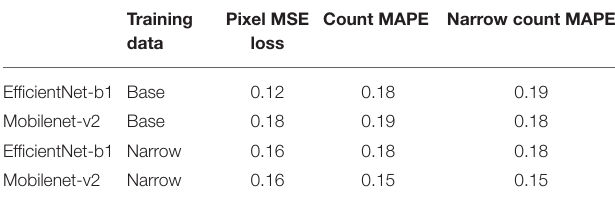
TABLE 2 | Density estimation model